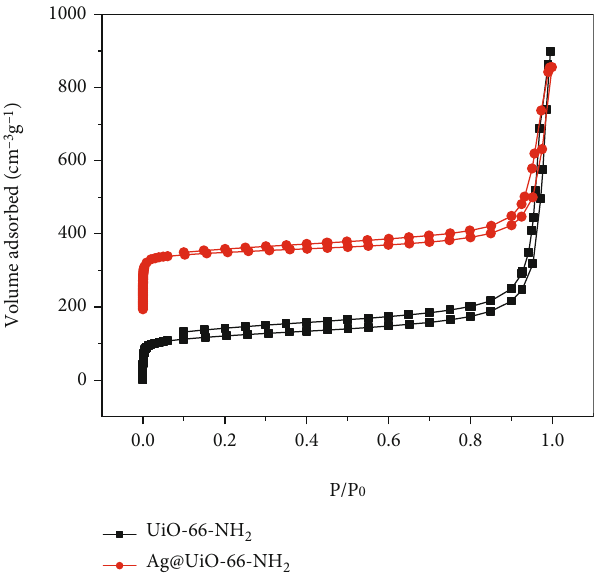
Figure 5: The N adsorption/desorption isotherms of UiO-66-NH 2 and Ag@UiO-66-NH . 2